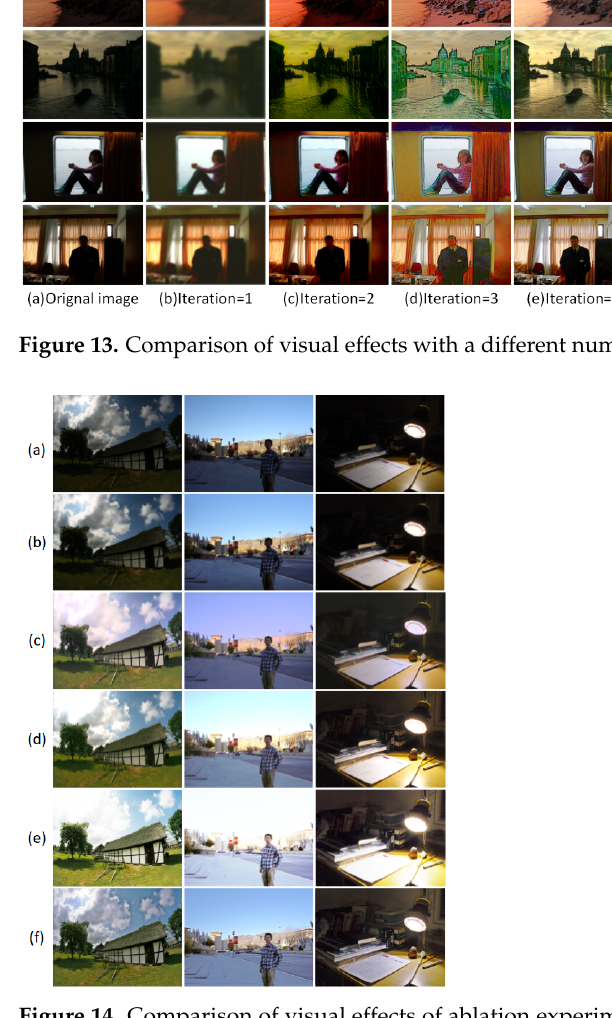
Figure 14. Comparison of visual effects of ablation experiments. ( a ) input image, ( b ) no exposure image generator, ( c ) no conversion to YCbCr color space, ( d ) no cross-fusion attention used, ( e ) no channel fusion attention used, and ( f ) the method of this